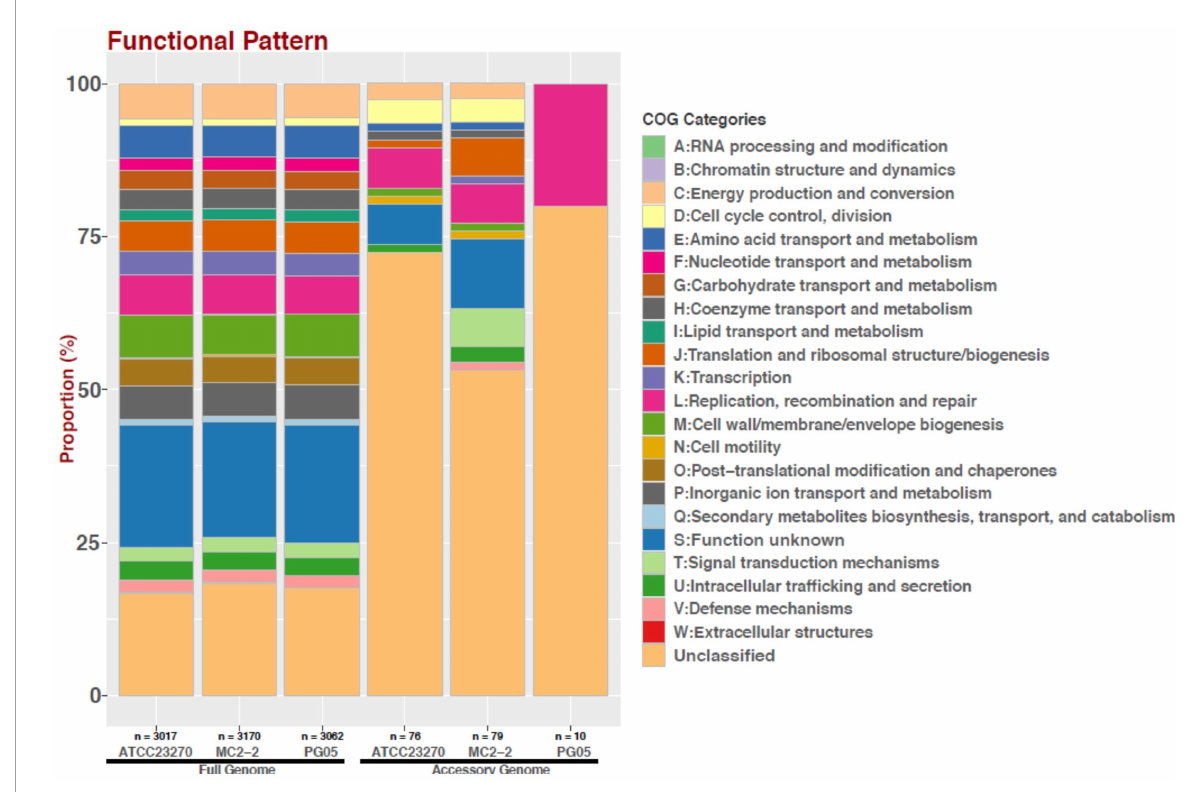
FIGURE7 Distribution of COG functional categories for full and accessory genomes of strains ATCC 23270, MC2.2 and PG05 of At. ferrooxidans